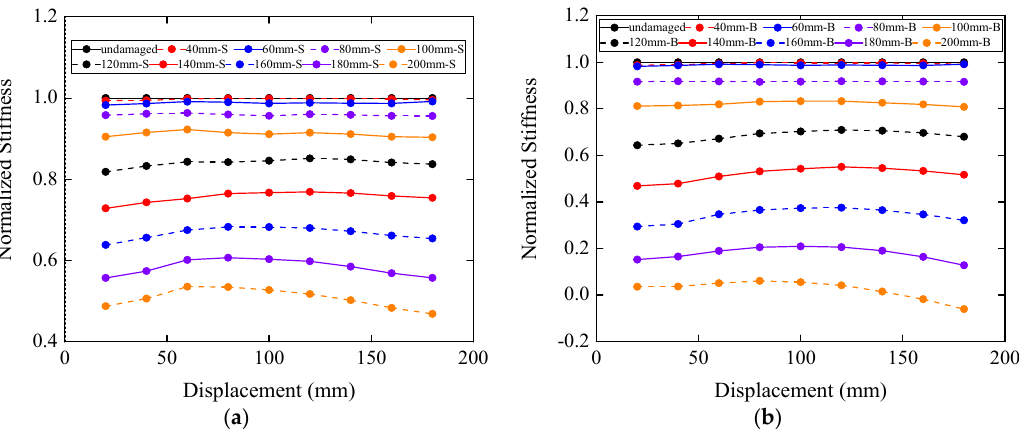
Figure 28. Normalized stiffness of damaged models: ( a ) Single tenon damaged; ( b ) both tenons damaged. Table 3. Averaged normalized stiffness (ANS) of damaged models.